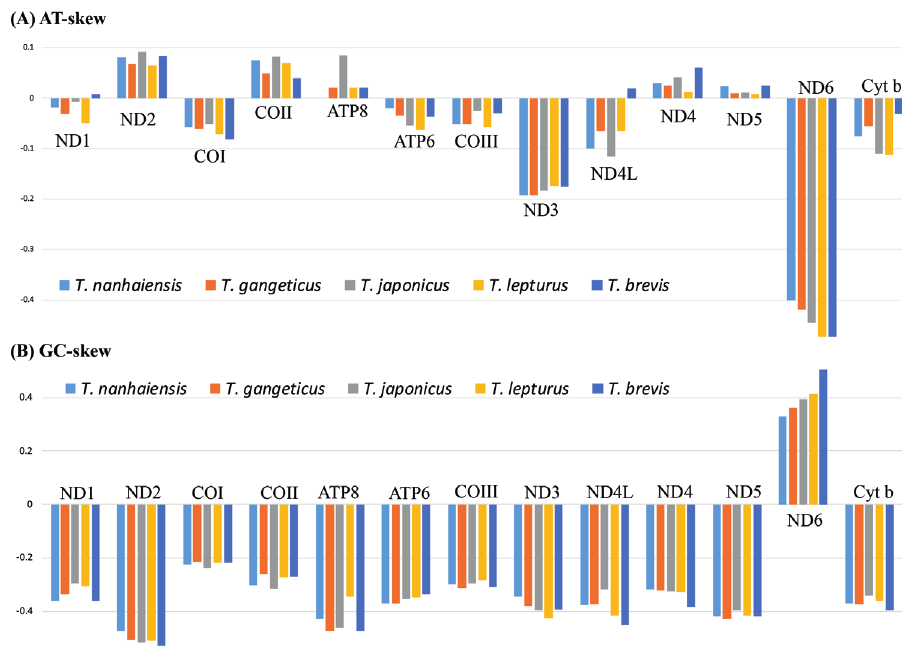
Figure 6. A AT-skew in 13genes. B GC-skew in in 13 genes.